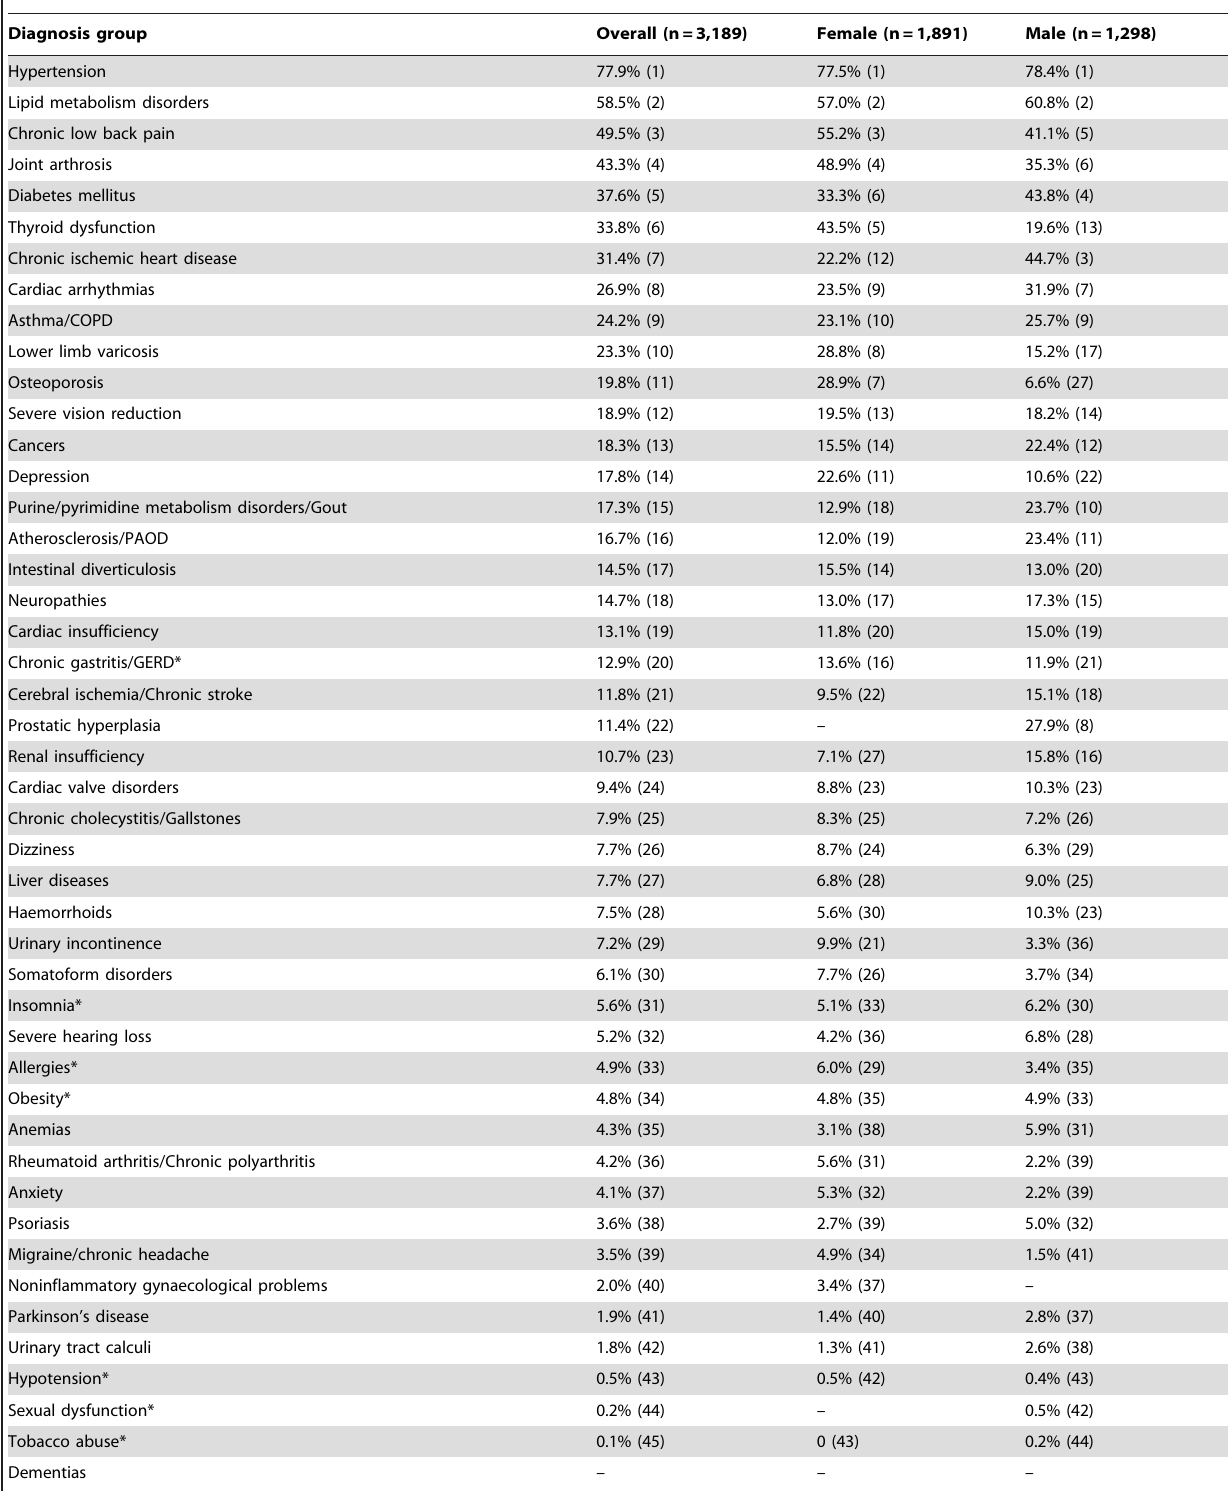
Table 2. Prevalence of diagnosis groups and rank order in the sample, overall and by